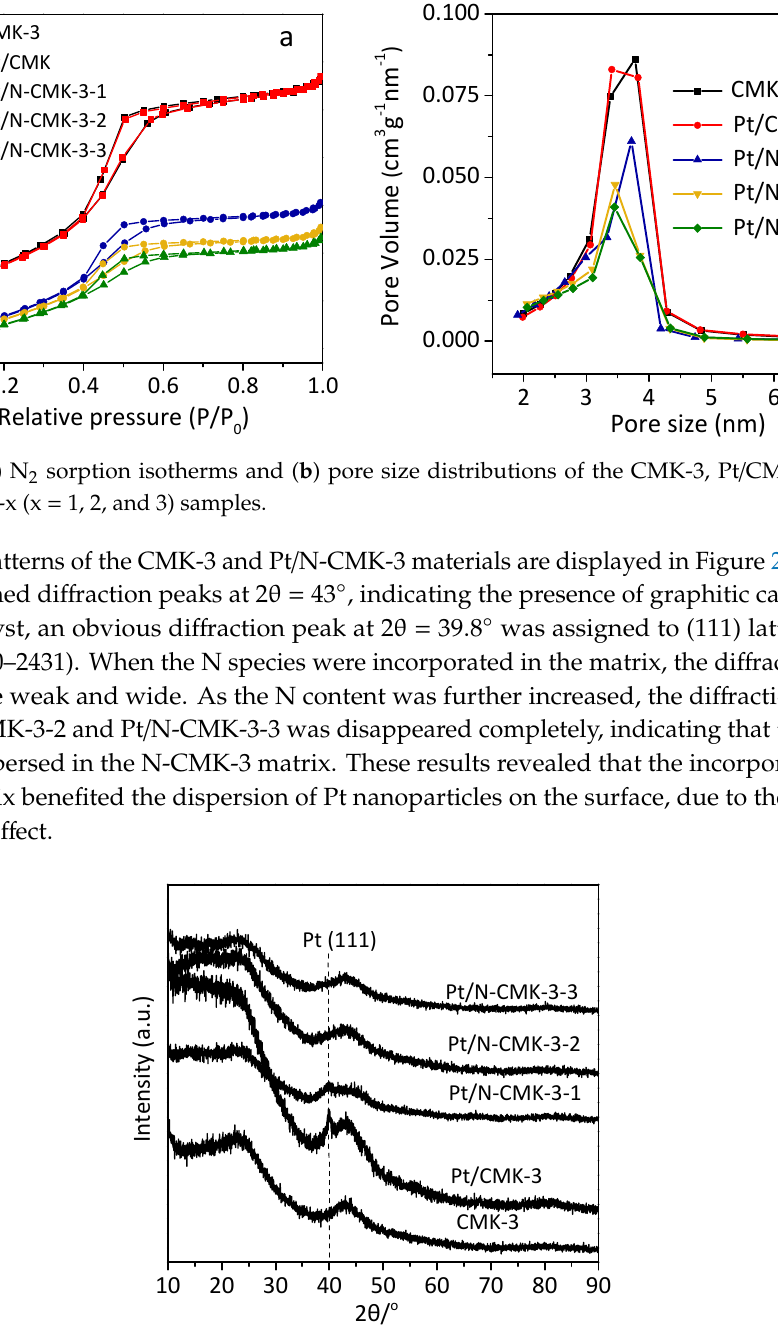
Figure 1. ( a ) N 2 sorption isotherms and ( b ) pore size distributions of the CMK-3, Pt/CMK-3, and Pt/N-CMK-3-x (x = 1, 2, and 3) samples.